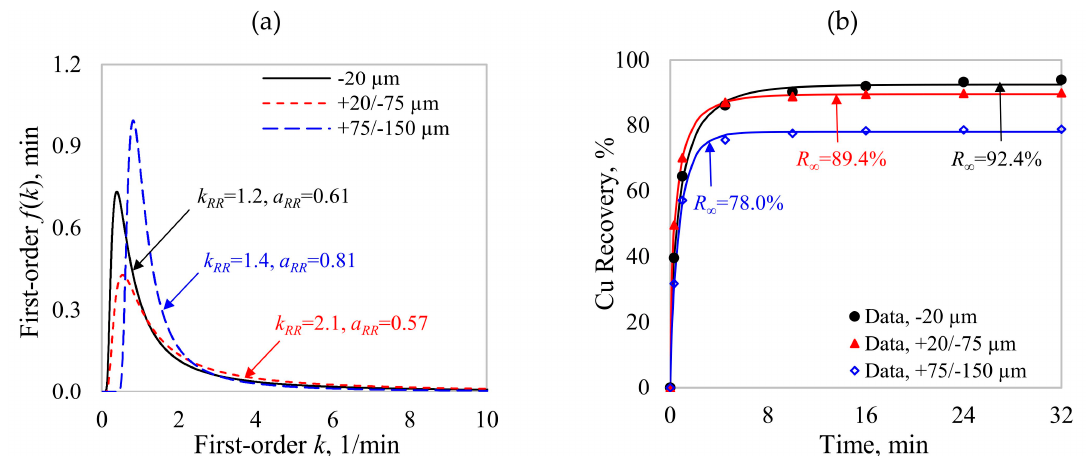
Figure 6. Examples of estimated f ( k )s and model fitting, size-by-size Cu results; ( a ) First-order f ( k )s, Equation (13), ( b ) Time-recovery data, continuous curves obtained by fitting the R ( t ) model of Table 5.